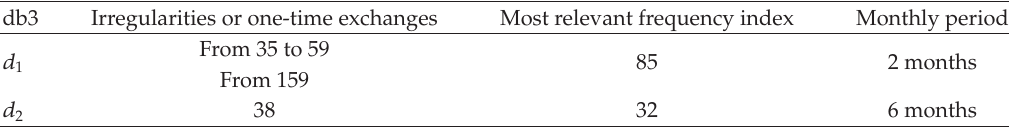
Table 6: Relevant frequency indices of SCTfe/Spain